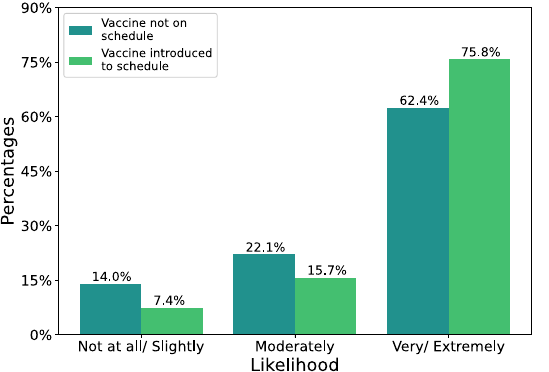
Figure 3. This figure shows the likelihood of participants vaccinating their future children against HAV, both before and after the vaccine is introduced into the schedule.